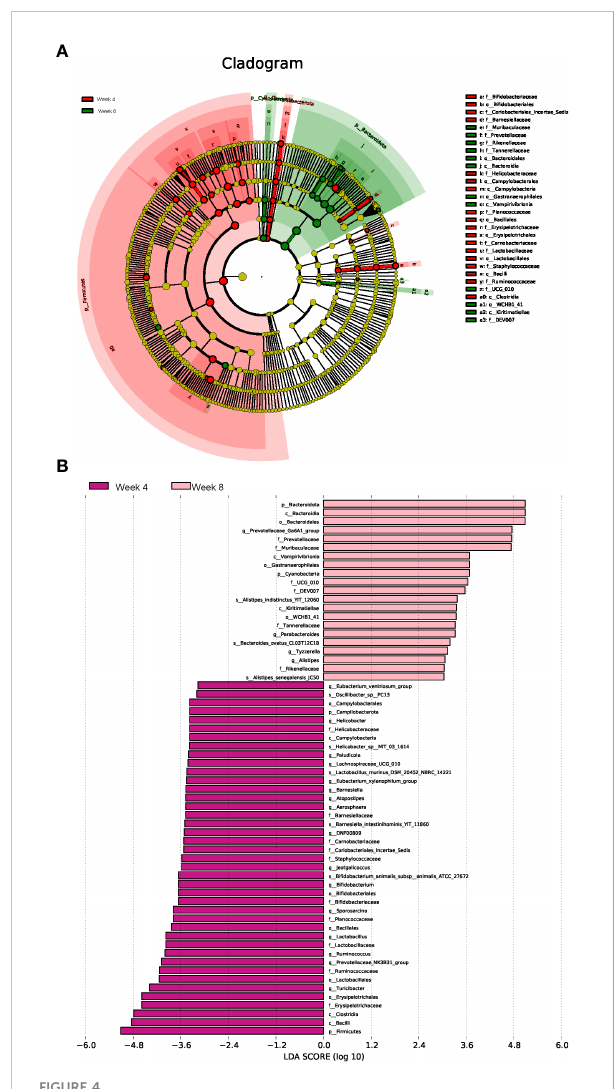
FIGURE 4 Linear discriminant analysis effect size (LEfSe) analysis. Cladogram (A) and histogram (B) illustrating the species responsible for discriminating the rats under 4 weeks of CUMS and 8 weeks of CUMS (n = 10 per